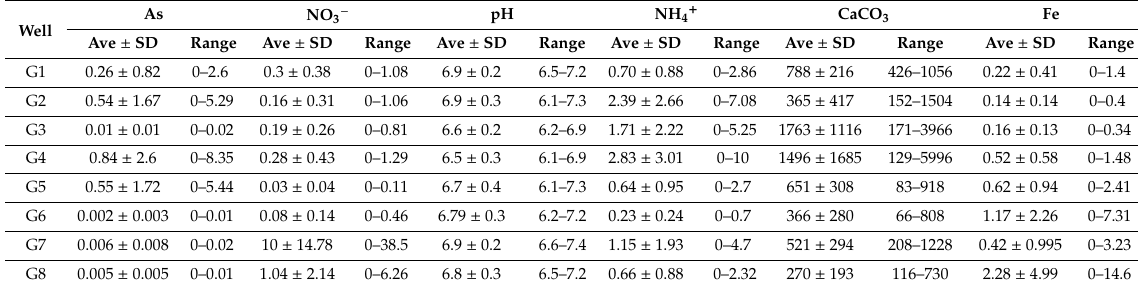
Table A2. Statistical summary of physico-chemical parameters for groundwater samples in the wet season in An Giang, during